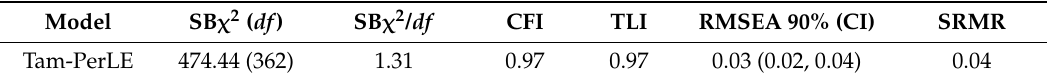
Table 3. Goodness-of-fit statistics for the Tam-PerLE